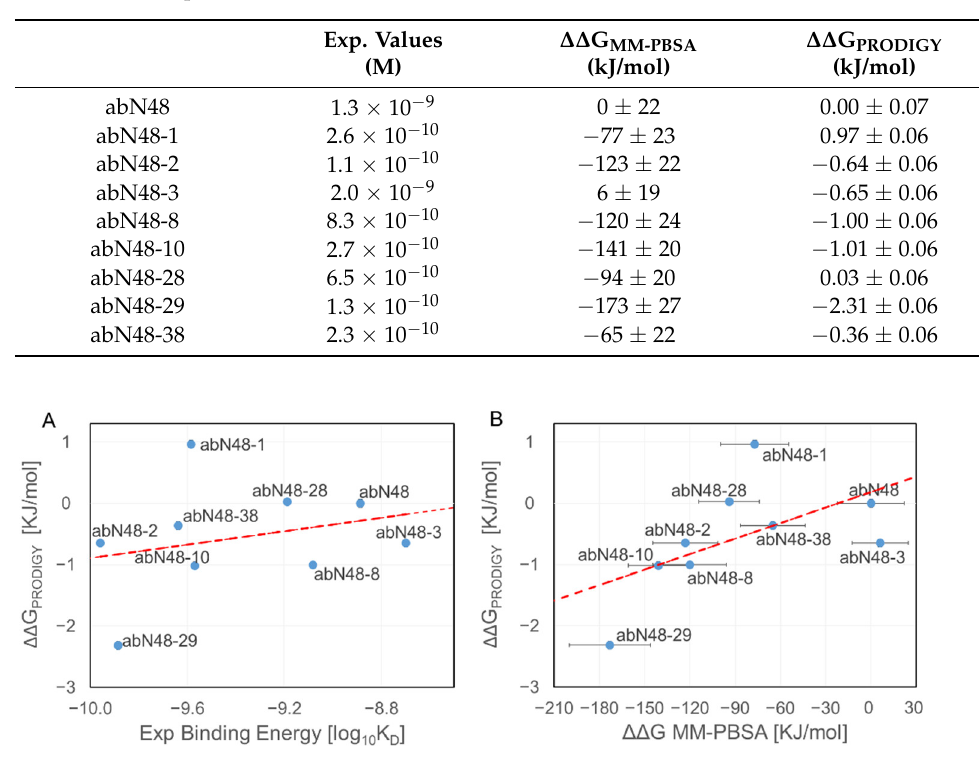
Figure 2. Binding affinity using the PRODIGY web server. The binding affinity of abN48 and all its mutants in complex with pepN9-19 was computed using PRODIGY. Calculations were done using the same configurations used in the MM-PBSA method. Results obtained with PRODIGY web server did not correlate with the log 10 of the experimental K D (( A ), R 2 = 0.07) and poorly correlated with MM-PBSA results (( B ), R 2 = 0.32).